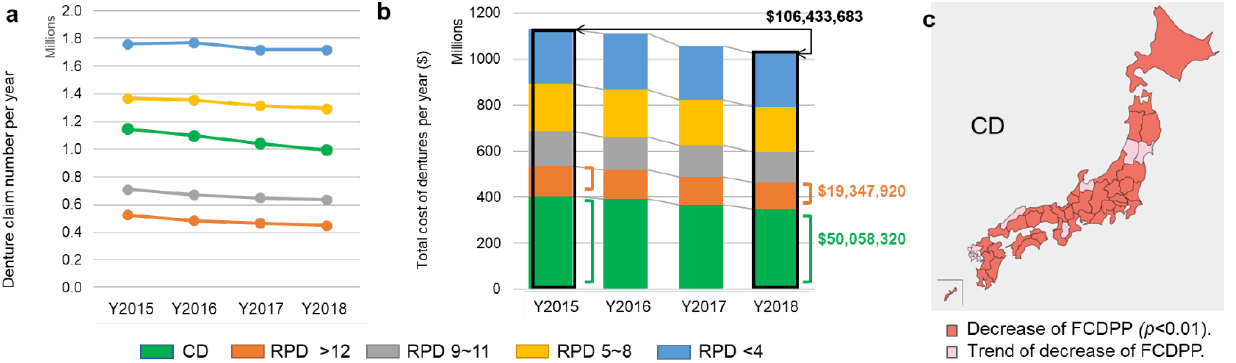
Figure 5. The trend of frequency of dentures under the 80/20 national campaign. ( a ): The number of dentures claims and expenditure from 2015 to 2018 in 5 types of dentures. The number of denture claims decreased over the year (R: − 0.99, p < 0.01, Spearman ’ s correlation coefficient) on CD, RPD > 12, and RPD 9 – 11 teeth. ( b ): Total cost of dentures from 2015 to 2018. The cost of dentures decreased from 1.128 to 1.022 billion dollars. A significant decrease (R= − 0.99, p < 0.01) was observed on CD and RPD for 12 – 14 teeth (respectively contributing to 49.9% and 10.2% decreased cost of $106,433,683, the sum of all four years). ( c ): The frequency of CD claims per dental practice (FCDPP) in each of the 47 states from 2015 to 2018. All states showed a trend of decrease, and 85% of states (40 states) had a statistically significant decline in use ( p < 0.01).